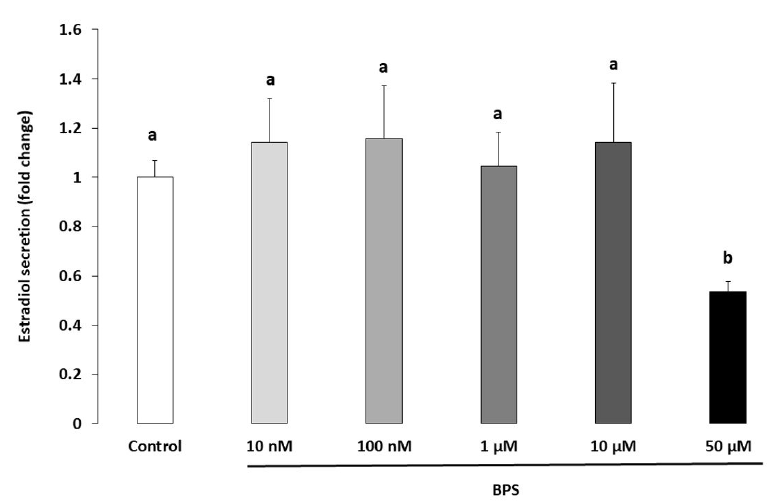
Figure 4. E ff ect of Bisphenol S (BPS) on human granulosa cell (HGC) oestradiol secretion. HGC underwent 48-h culture in the presence or absence of BPS (10 nM, 100 nM, 1 µ M, 10 µ M or 50 µ M). The oestradiol concentration was measured in culture media, and its value was normalised by the protein concentration in each well. Data are expressed as pg oestradiol per µ g protein and normalised to the control condition. The results of seven independent experiments are presented as mean ± standard error of the mean (SEM). Bars with di ff erent superscripts indicate a significant di ff erence ( p ≤